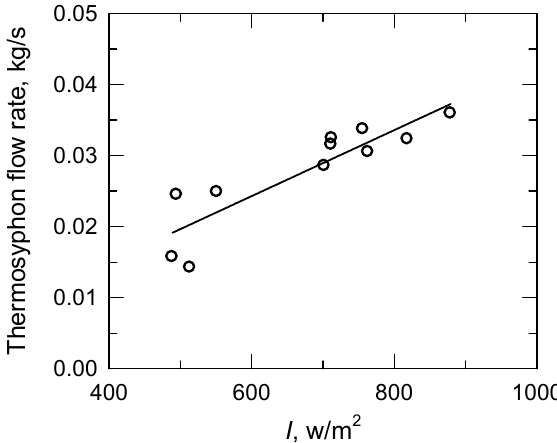
Figure 4. Thermosyphon flow rate, no-load case.